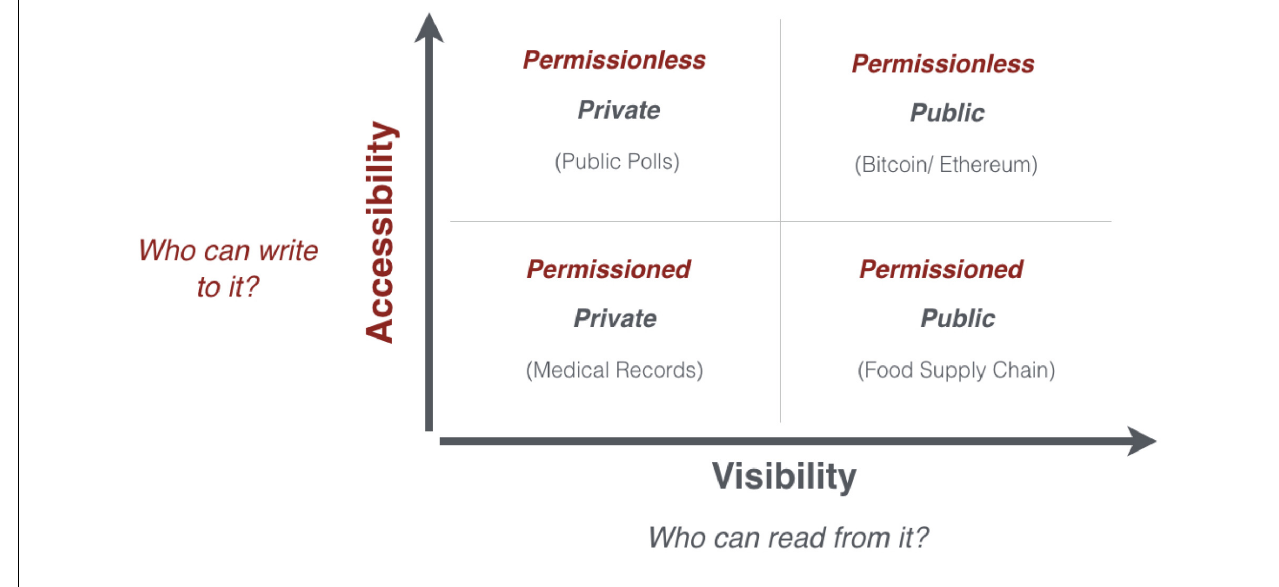
FIGURE 2 | Blockchain systems accessibility and visibility matrix.